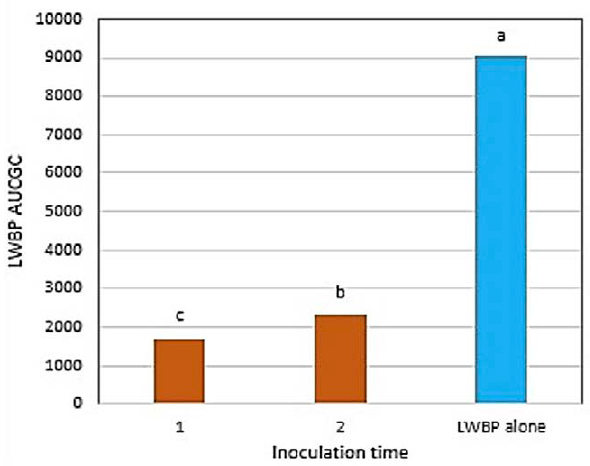
Figure 8. Effect of grafting time (simultaneous and non-simultane- ous) on concentration of lime witches’ broom phytoplasma (LWBP) in mixed infection with alfalfa witches’ broom, rapeseed phyllody, sesame phyllody and tomato witches’ broom phytoplasmas as com- pared with those grafted with LWBP alone: LWBP AUCGC, area under concentration growth curve of LWBP. 1, non-simultaneous and 2, simultaneous grafting. 1 and 2 are means of the four mixed inoculations. Means accompanied by different letters are signifi- cantly different ( P ≤